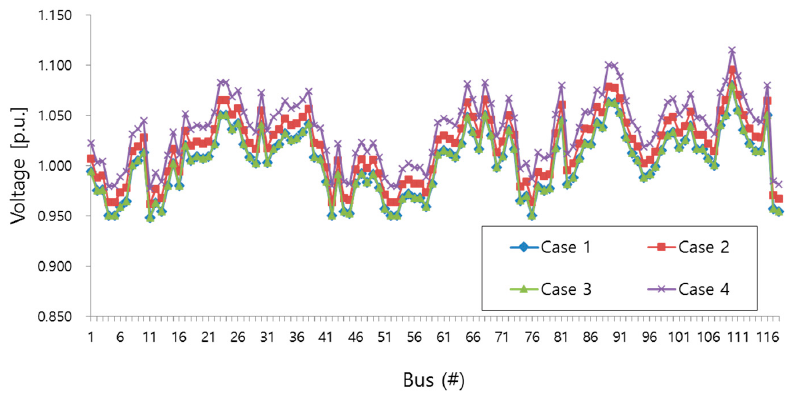
Figure 8. Comparison of the voltage deviation for each case in the modified IEEE-118 bus system.